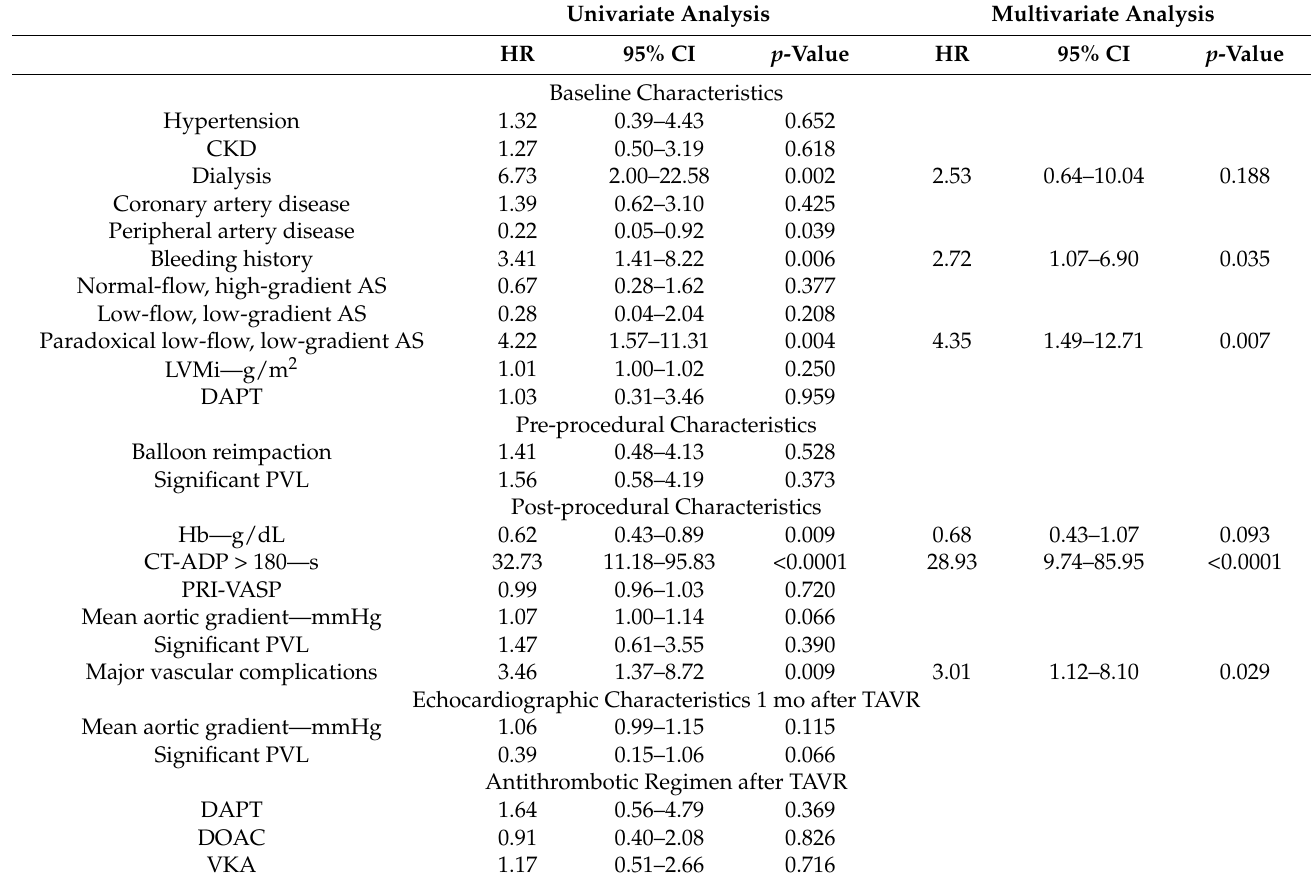
Table 4. Predictors of late